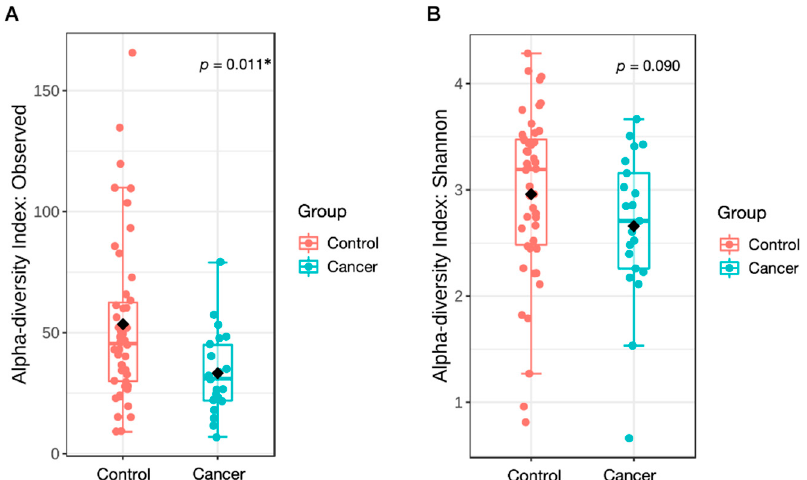
Figure 2. Reduced α -diversity in the gastric microbiota of patients with cancer than that in the controls. Boxplots represent the α -diversity measured using ( A ) observed amplicon sequence variants (ASVs) and ( B ) Shannon index at ASV level. Mann–Whitney test was used to compare the microbial diversity between the two groups. * p < 0.05. The median line, box, and whiskers indicate the median value, 25th and 75th percentiles, and 1.5 interquartile ranges, respectively.